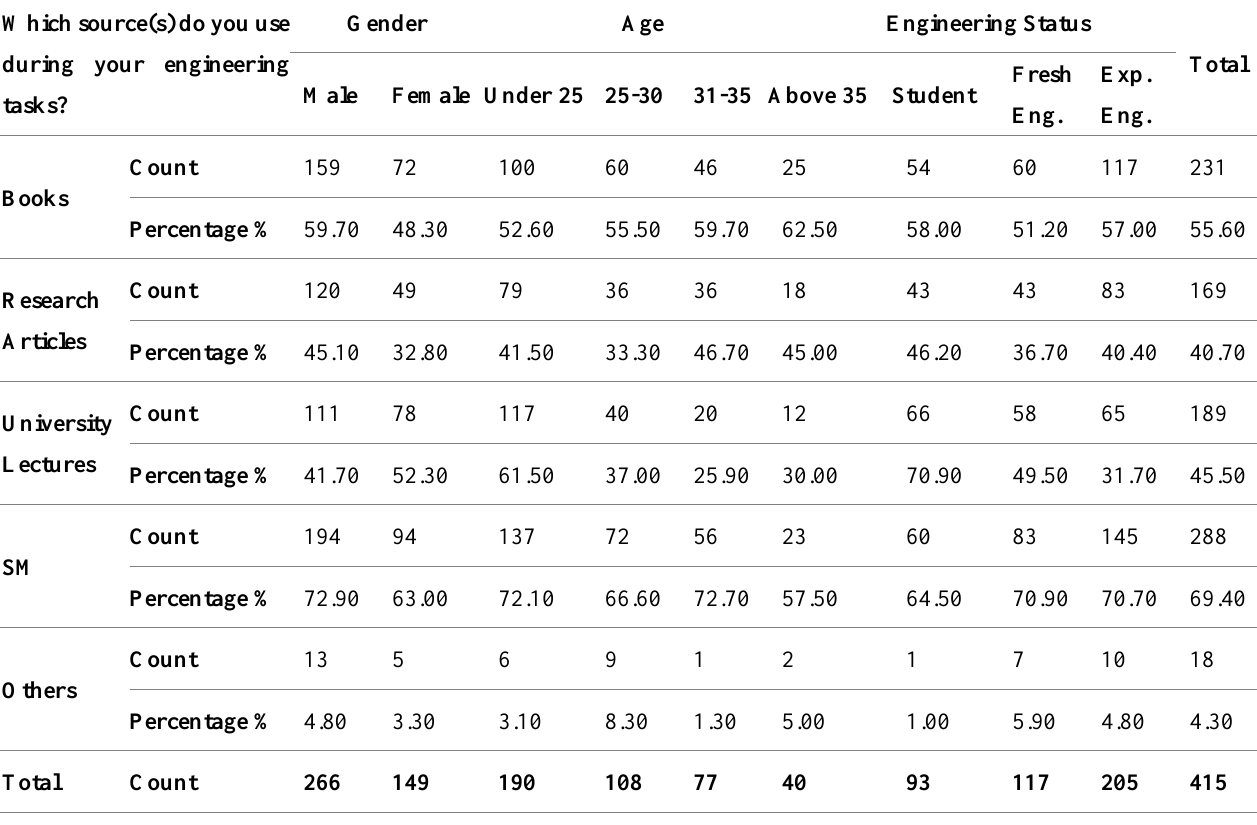
Table 2. Engineering Sources of Knowledge Which source(s) do you